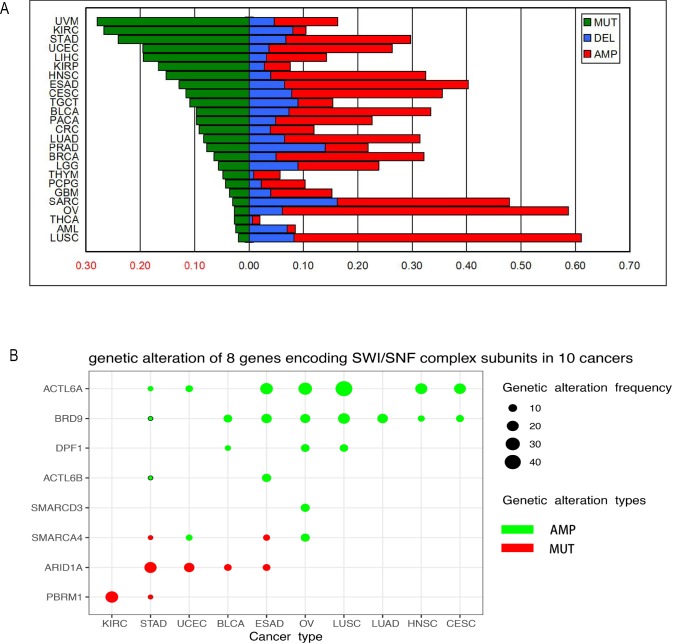
SWI/SNF complex mutations are quite pervasive within a wide range of human cancers.(A) This bar chart shows the genetic alteration frequency of the SWI/SNF complex within 25 types of cancers. Green indicates point mutations, blue indicates deletions, and red indicates amplifications. It is clear that the copy number variation (CNV) frequency of the SWI/SNF complex within 25 types of cancers constitutes a large proportion of the chart. There are 14 cancers in which the CNV frequency of the SWI/SNF complex exceeds 20%. However, for point mutations, there are only 3 types of cancers (melanoma, ccRCC, and stomach cancer) with frequencies above 20%. (B) This figure shows the genetic alteration frequency of 8 subunits among 10 cancer types. Red indicates point mutations, and green indicates CNVs. The differing sizes of the bubbles represent the genetic alteration frequency of each subunit among 10 cancer types. Larger bubbles indicate a higher genetic alteration frequency of subunits within these cancer types.